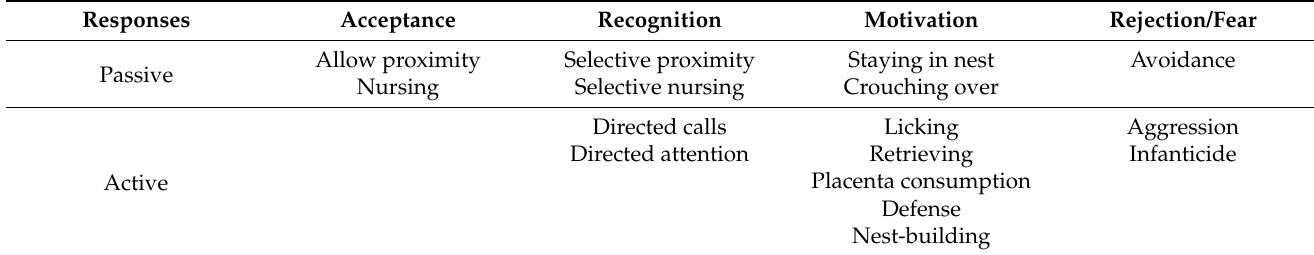
Table 1. Examples of active and passive maternal behaviors that are associated with processes of acceptance, recognition, motivation, and